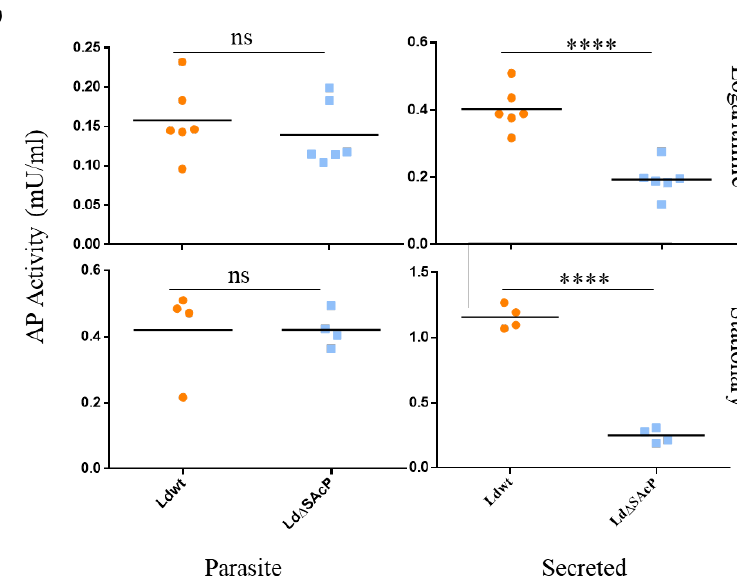
Figure 3. Confirmation that the SAcP protein is lost in Ld ∆ SAcP. ( a ) Western blot analysis of SAcP in L. donovani 1S2D wild type (LdWT) and L. donovani mutant (Ld ∆ SAcP) strains. Cell lysates (p = parasite-contained proteins) and cell-culture supernatants (s = secreted proteins) were Western blotted using the α -SAcP primary rabbit antibody. No remaining SAcP is detected in the Ld ∆ SAcP strain. HSP83 was used as a loading control for the cell lysate. Full, uncropped image available in Figure s2. ( b ) Acid phosphatase activity was measured in the parasite-contained proteins and in the secreted proteins in the L. donovani 1S2D wild type (shown in orange) and mutant parasites (shown in blue) during logarithmic ( n = 6, parasite p -value = 0.4749, secreted p -value = 9.383 × 10 − 5 ) and stationary phases of growth ( n = 4, parasite p -value = 0.9926, secreted p -value = 2.435 × 10 − 6 ), ns > 0.05, **** p < 0.0001.